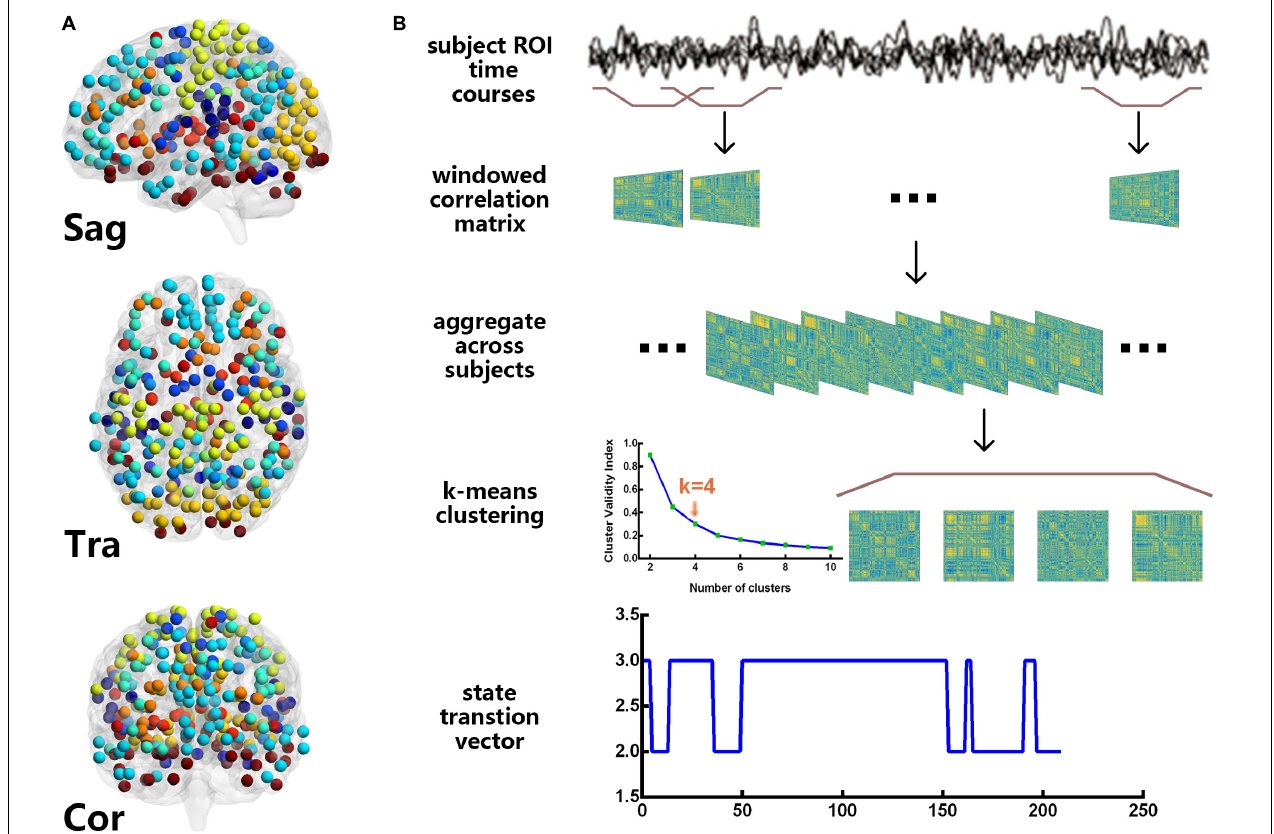
FIGURE 1 | Power 264 atlas (A) and the flowchart of the dynamic functional connectivity analysis (B) . For these resting-state functional magnetic resonance imaging data, we used the sliding window approach to obtain 209 time windows and clustered the windows for all participants by the k-means algorithm. The cluster centroids and cluster membership assignments that were obtained for all the windows represented the state transition